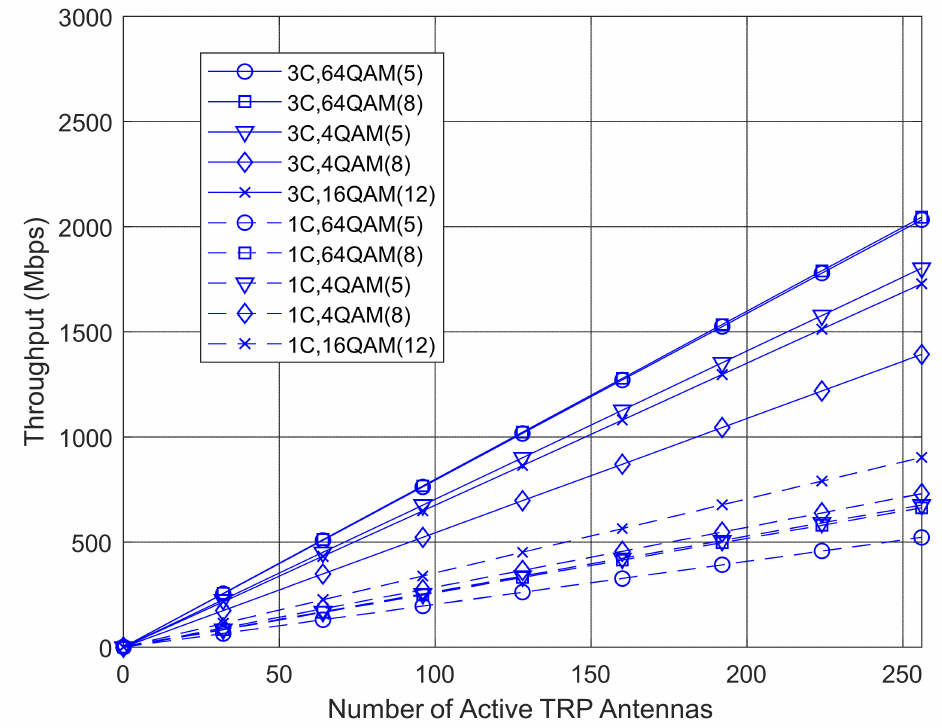
Figure 10. Throughput vs. number of active TRP antennas, for UMa scenario, N rx = 5, for two C-RAN cluster sizes, modulations and numbers of antennas per user, namely with N tx /N u = 5, 64QAM(5) and 4QAM(5); with N tx /N u = 8, 64QAM(8) and 4QAM(8); and with N tx /N u = 12,